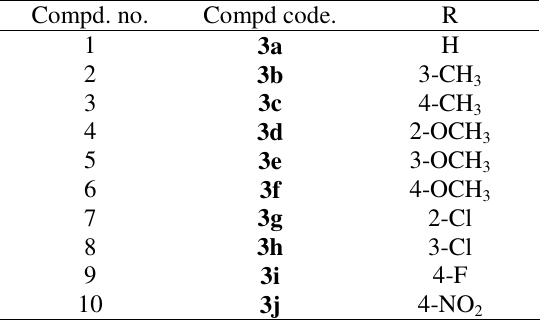
Table 1. Substituents of compounds